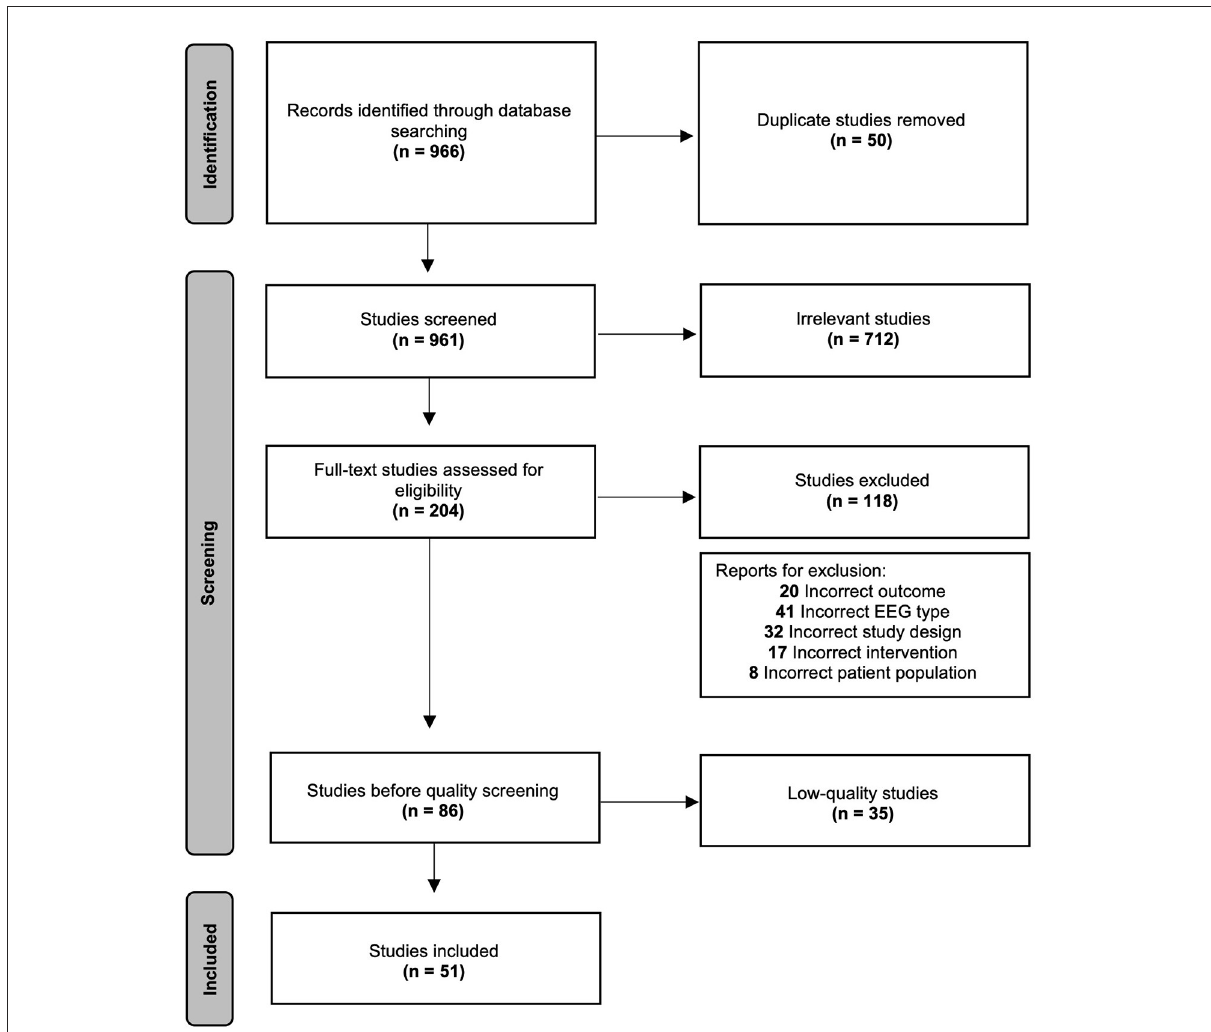
FIGURE1 Preferred reporting items for systematic reviews and meta-analysis (PRISMA) flow